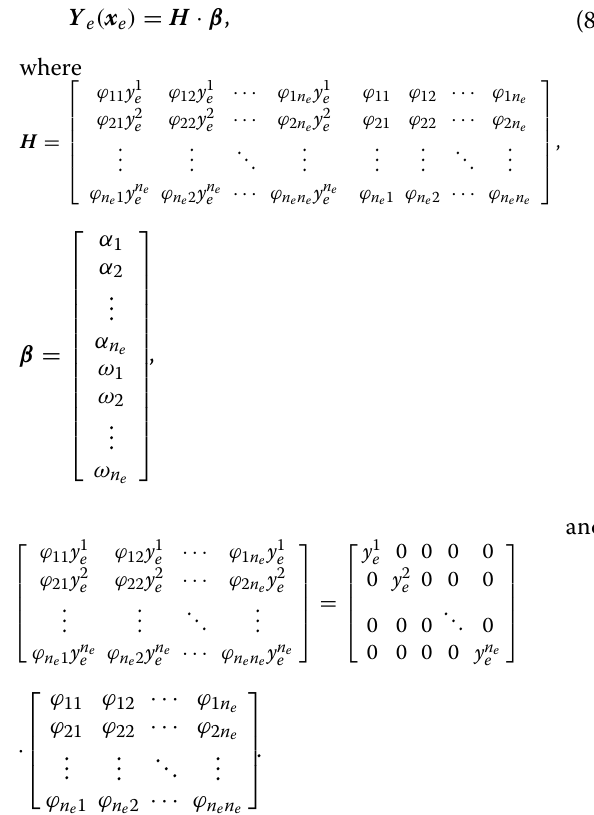
In this study, the shape parameter, σ , in the basis func-